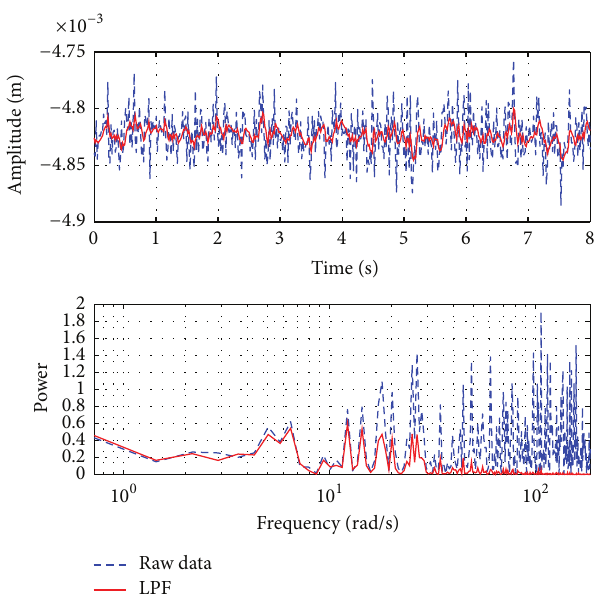
Figure 5: Time history and FFT analysis result of measurement signal with low-pass